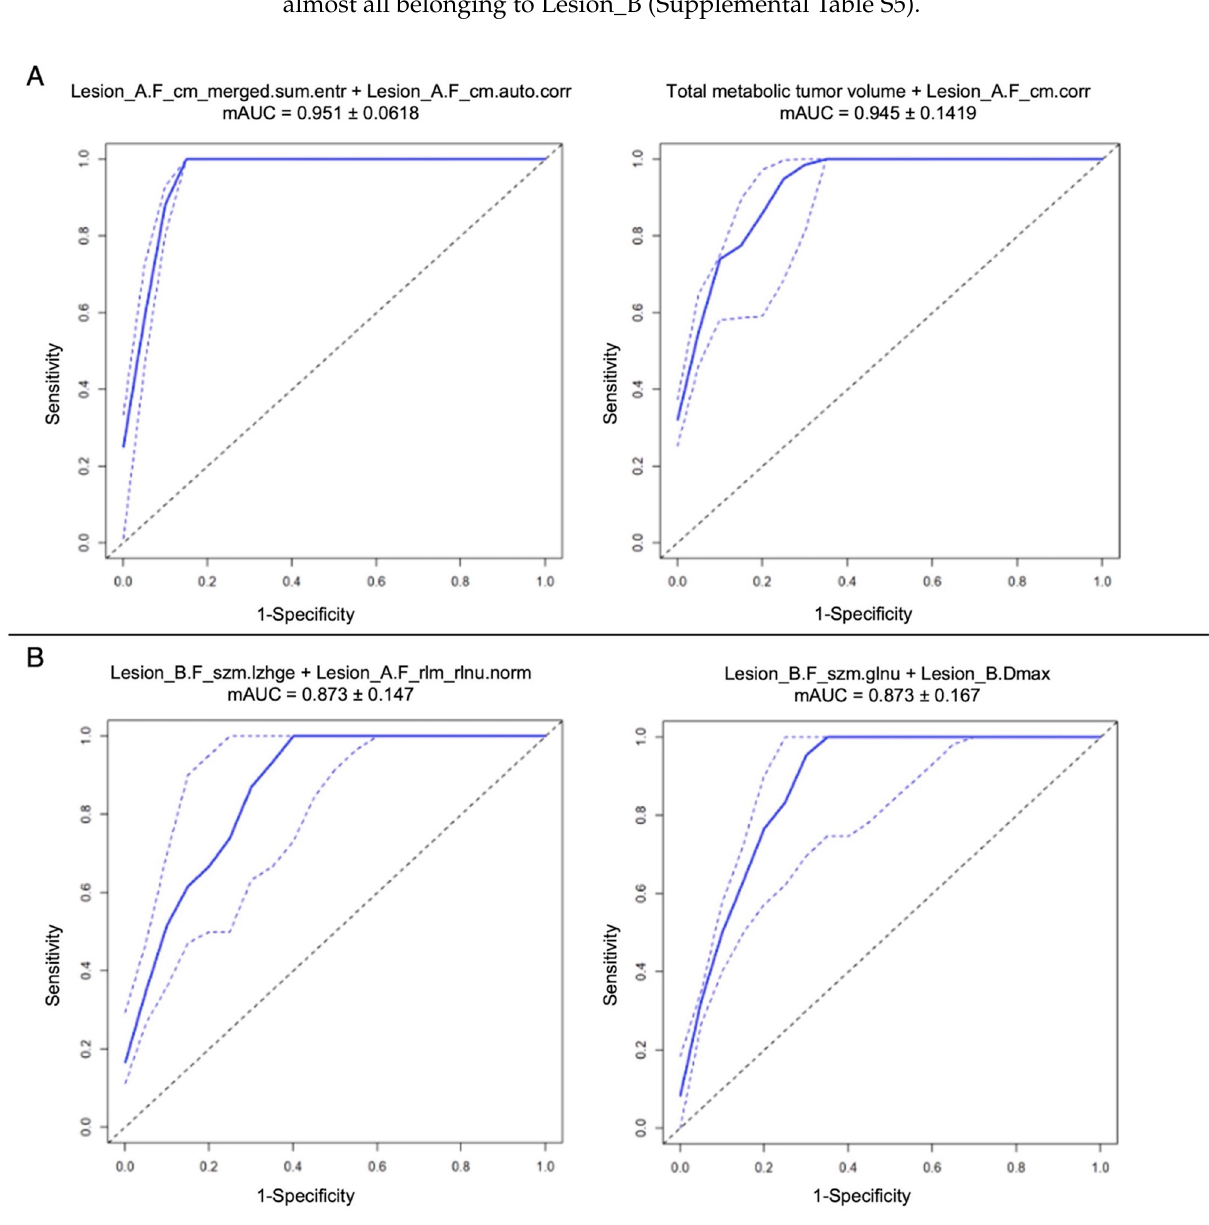
Figure 6. First two best bivariate radiomic models at cross-fold validation test for DS prediction with data obtained from Scanner_1 images ( A ) and for 24-month PFS prediction with data obtained from Scanner_2 images ( B ). The continuous blue line represents mAUC. The dotted blue lines represent +/ − standard